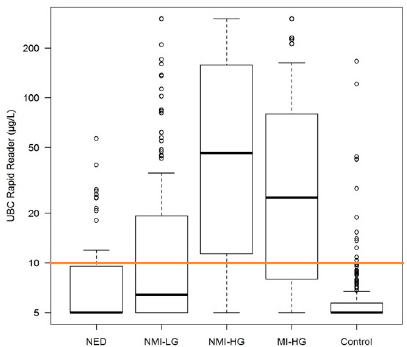
Figure 3. Box plot for non-evidence of disease (NED), non-muscle-invasive low grade (NMI-LG), non-muscle-invasive high grade (NMI-HG), muscle-invasive high grade (MI-HG), control. Orange line for cut-off at 10 µg/L.